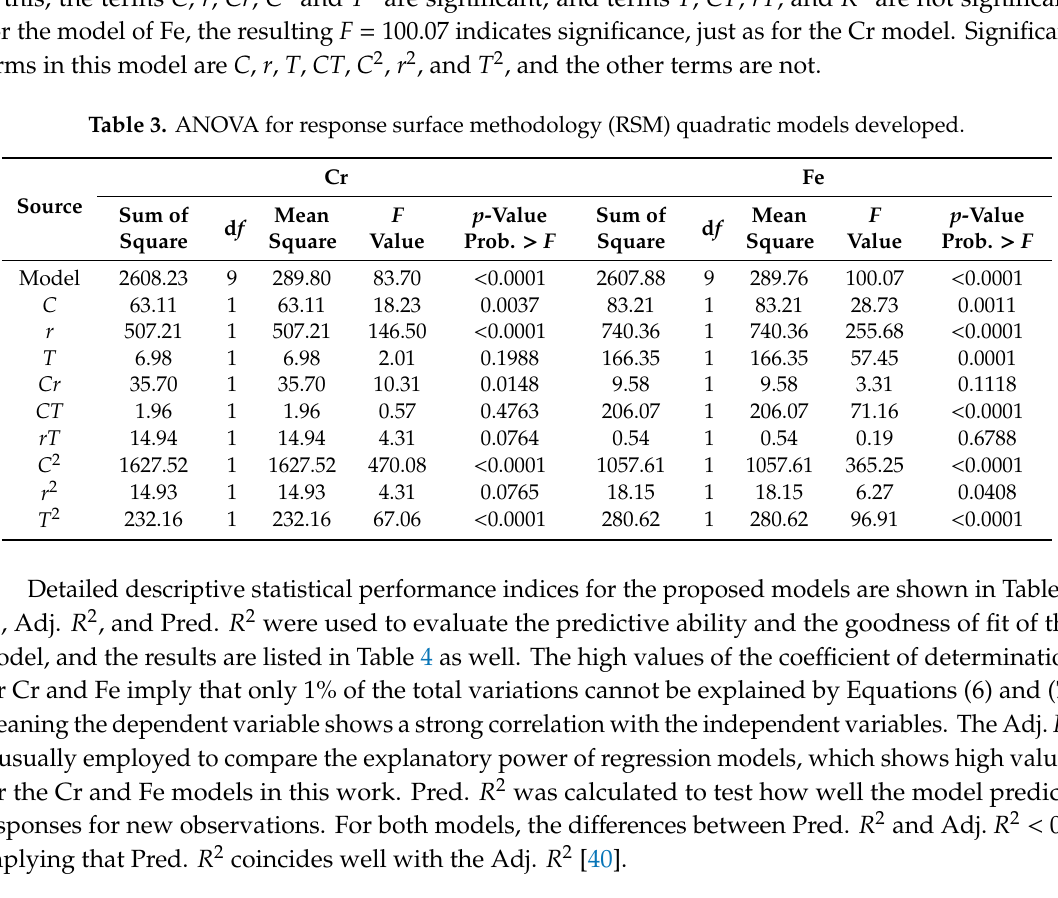
Table 4. Detailed descriptive statistical regression analysis for the